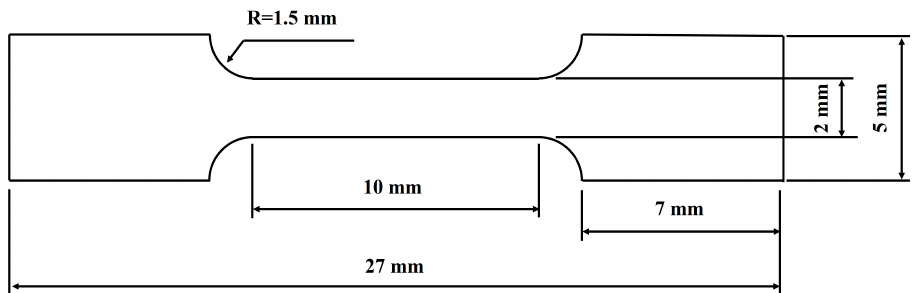
Figure 3. Schematic of the tensile-test samples.